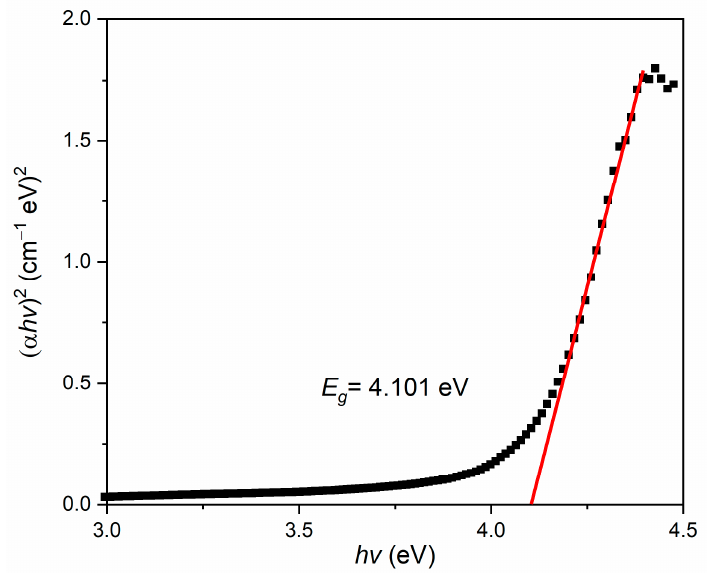
Figure 6. Energy band gap of the NCC thin film.